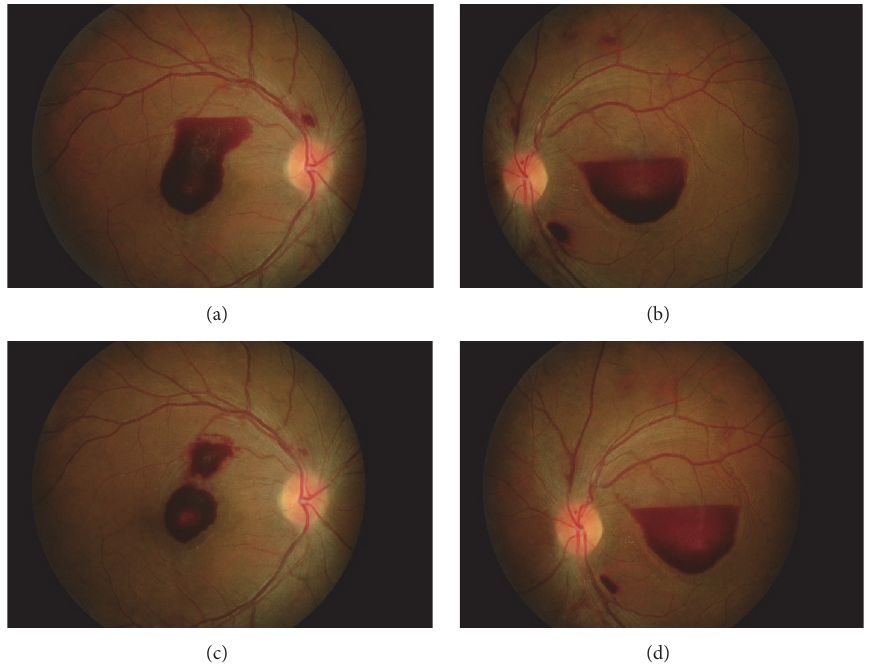
Figure 1: Case 1 at initial presentation and at 1 week after right intravitreal ranibizumab. Notes: (a) premacular haemorrhage at initial presentation in the right eye, (b) premacular haemorrhage at initial presentation in the left eye, (c) partial resolution of premacular haemorrhage in the right eye at 1 week after right intravitreal ranibizumab, and (d) minimal resolution of premacular haemorrhage in the left eye at 1 week after right intravitreal